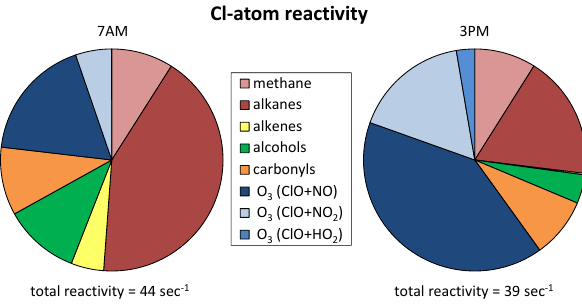
Fig. 4. Modeled Cl · reactivity at 07:00 model time (left panel) and 15:00 model time (right panel) grouped by reactant